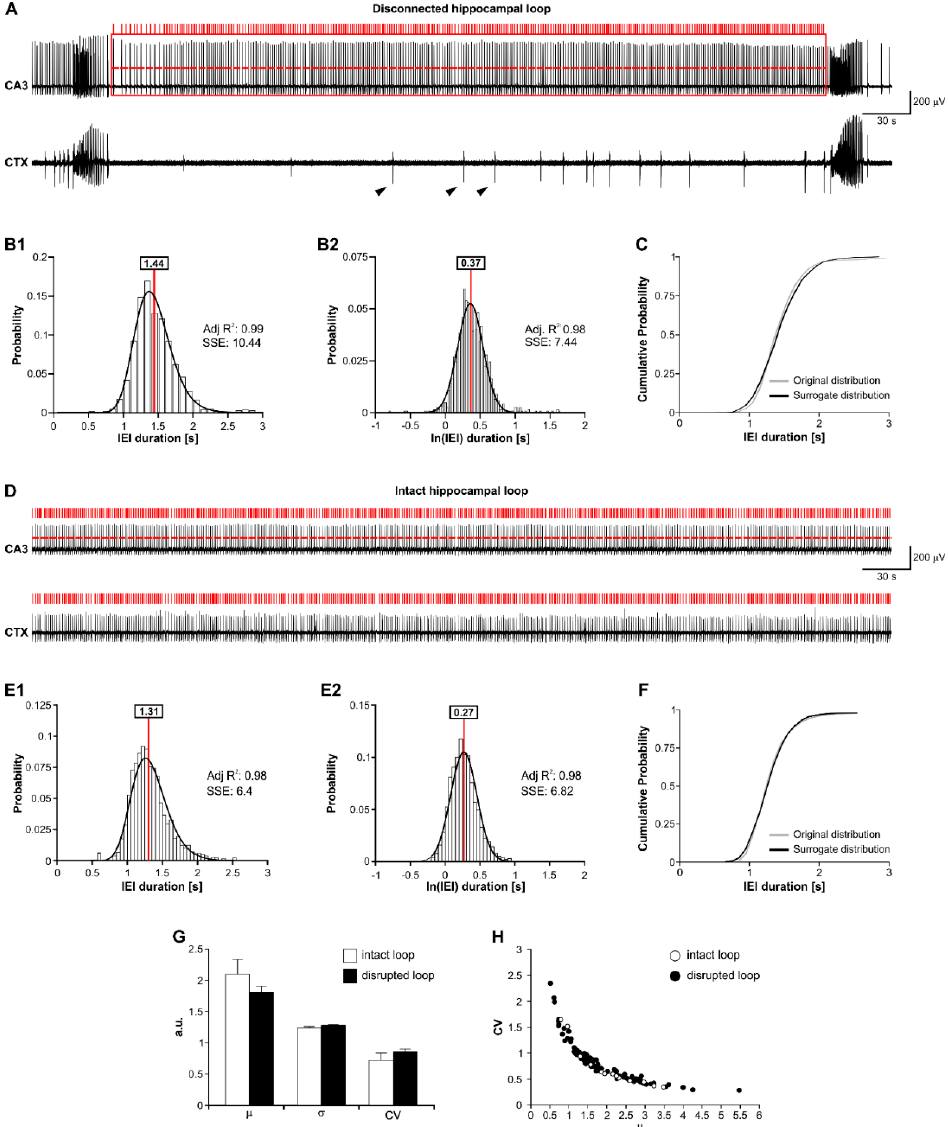
Figure 2. The fast CA3-driven interictal activity follows lognormal temporal dynamics. ( A ) Selection of one interictal period generated by the hippocampal subfield CA3 in a disconnected brain slice. ( B1 ) Lognormal fit (solid line) of the IEI distribution from the experiment in ( A ). ( B2 ) Gaussian fit (solid line) of the ln-transformed IEI (from ( B1 )). ( C ) The cumulative probability curve of ln- transformed IEI (from ( B1 )) is statistically similar to a surrogate normal distribution with the same µ and σ of the original data. ( D ) MEA recording of one interictal segment in a connected brain slice. ( E1 ) Lognormal fit (solid line) of the IEI distribution from the experiment in ( D ). ( E2 ) Gaussian fit (solid line) of the ln-transformed IEI (from ( E1 )). ( F ) The cumulative probability curve of ln- transformed IEI (from ( E1 )) is statistically similar to a surrogate normal distribution with the same µ and σ of the original data. ( G ) Distribution parameters of the IEI in connected and disconnected brain slices. ( H ) CV/ µ relationship in connected and disconnected brain slices, exhibiting a similar power-law